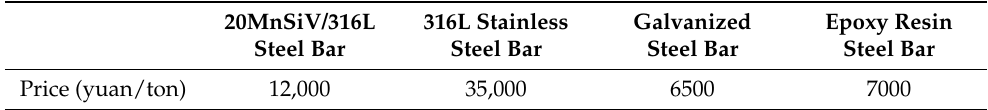
Table 1. Prices of different corrosion resistant steel